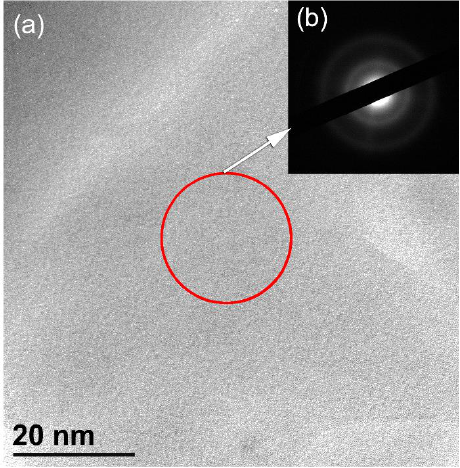
Figure 3. ( a ) BFI and ( b ) SADP of MD LaNi 3 powders obtained after high energy ball milling for 100 h. The circular symbol indexed in ( a ) denotes to the selected zone used to get the electron diffraction